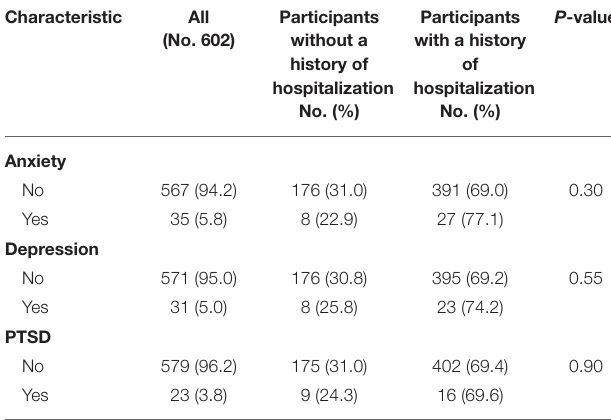
TABLE 1 | Sociodemographic characteristics of the participants. Characteristic